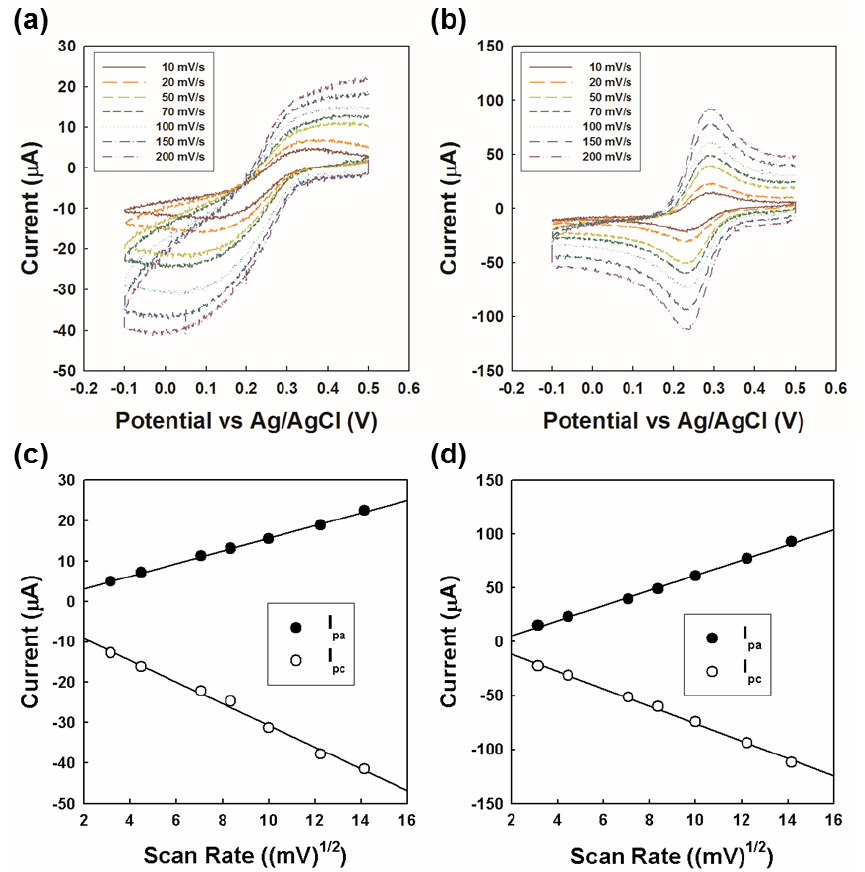
Figure 6. Cyclic voltammograms of ( a ) the graphite foil and ( b ) all-carbon electrode after 250th rolling cycles in 1.0 mM K Fe(CN) in DI water with addition of 0.1 M KCl at 3 6 potential scan rates ranging from 10 to 200 mV/s. The corresponding peak current dependence on the square root of scan rate in ( c ) the graphite foil and ( d ) all-carbon electrode after 250th rolling cycles.